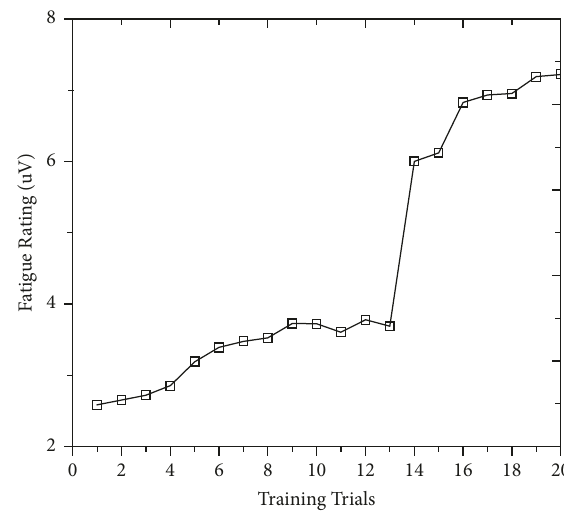
Figure 9: The measured rates of